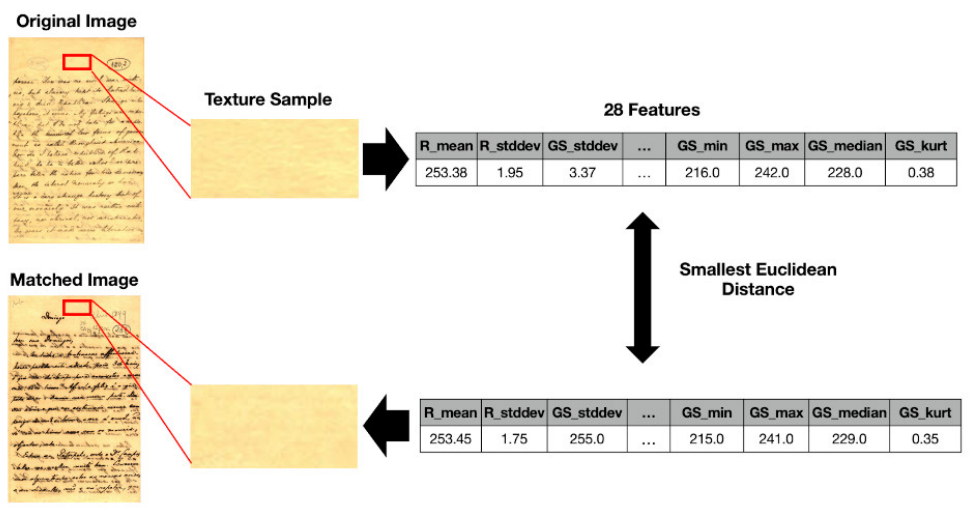
Figure 3. Example of matching real-world images by